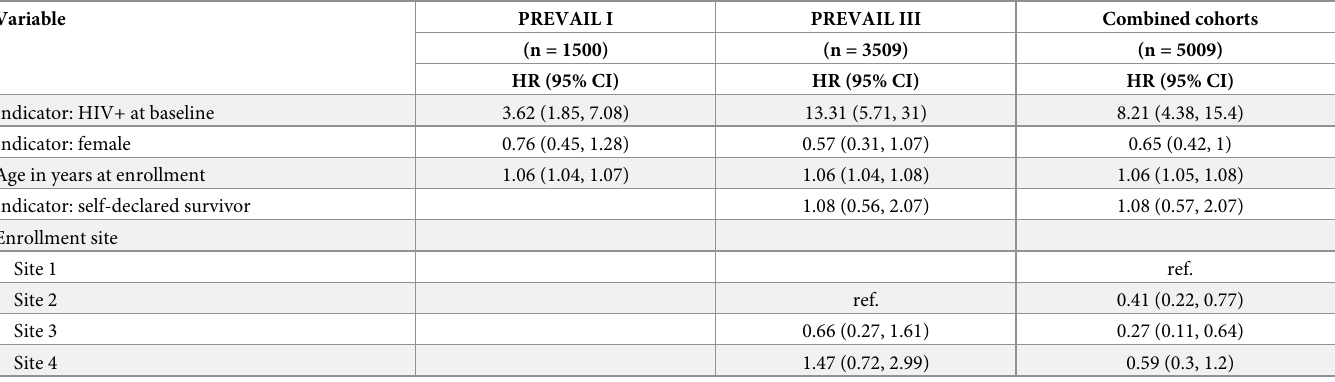
Table 3. Adjusted hazard ratios and 95% confidence intervals for all-cause mortality by cohort.